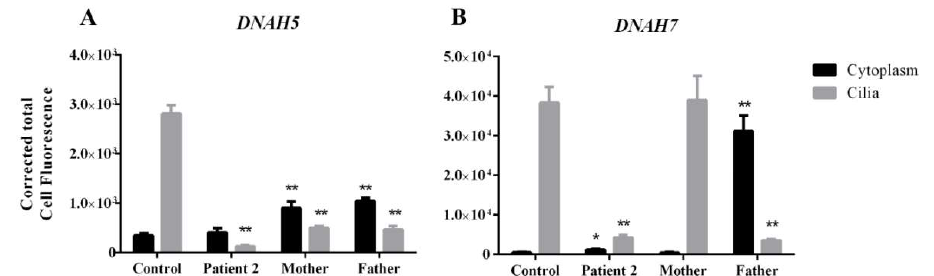
Figure 6. Corrected total cell fluorescence from immunofluorescence images obtained after immunofluorescence experiences with DNAH5 ( A ) and DNAH7 ( B ) antibodies, and calculated from the measurements obtained from the ImageJ software. Statistical significance determined using the Mann–Whitney test, with alpha < 0.05. * = p value < 0.05 ** = p value < 0.01.